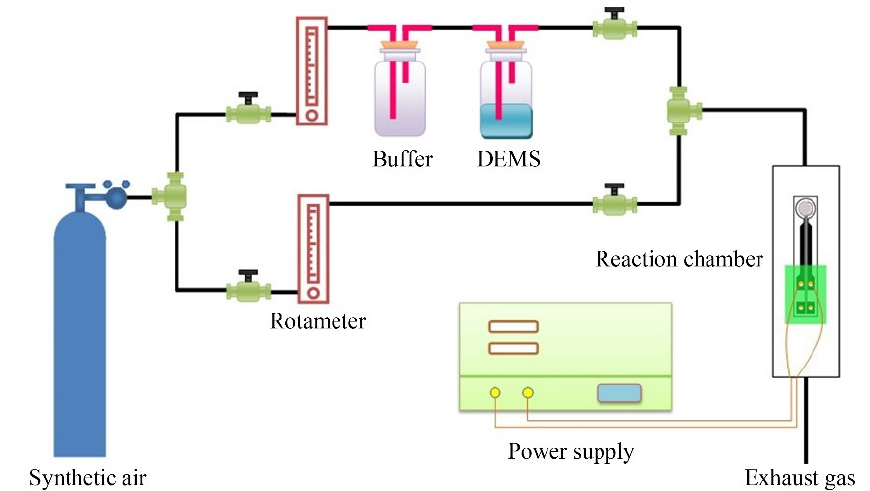
Figure 2. Schematic diagram of the chemical vapor deposition device. Table 1. The temperatures of the sensors and the power supplied.